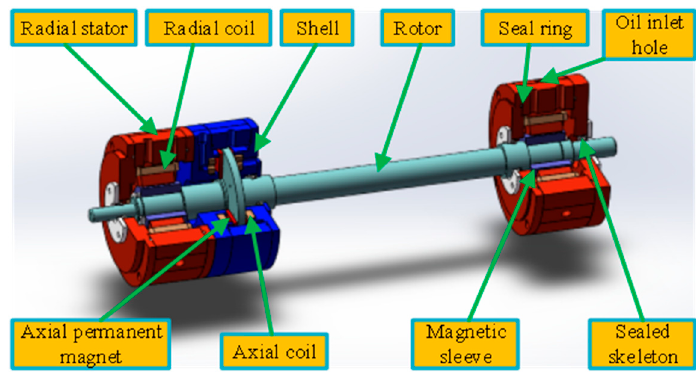
Figure 1. Magnetic fluid bearing system.